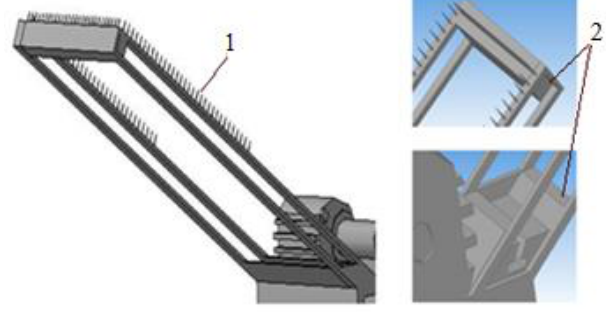
Fig. 3. Model of the frame with a rollout device.